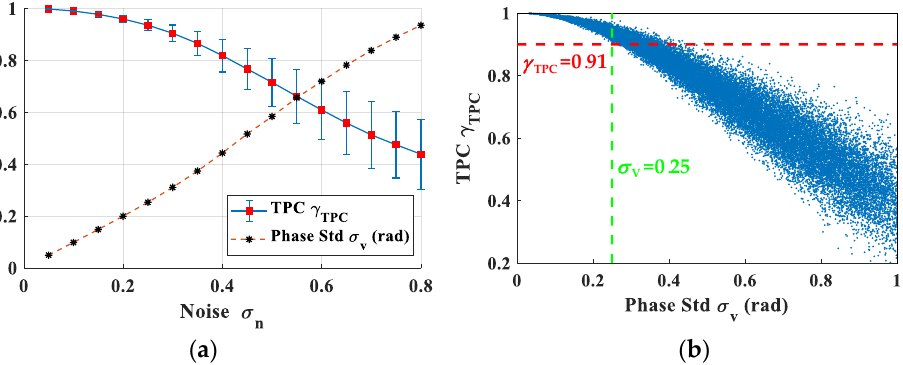
Figure 2. Numerical simulation results. ( a ) Variation curves of the temporal phase coherence (TPC) γ TPC and phase std σ V with the noise deviation σ n ; ( b ) scatter map of γ TPC with σ V . To better illuminate the relationship between the TPC γ TPC and the ADI D A , Figure 3a shows the scatter map of γ TPC with D A . By setting two proper thresholds of γ T and D T , those pixels with γ TPC ≥ γ T and D A > D T in the set S 3 could be selected as QPSs. For those pixels with the ADI D A lower than 0.25, and belonging to S 1 + S 2 , their TPC values are between 0.91 and 0.99 (90% confidence interval). The mean values (solid line) and the dispersion (error bars) of γ TPC with D A , are shown in Figure 3b. When D A equals to 0.25, the variation range of γ TPC is about from 0.91 to 0.96. Moreover, for those pixels with the TPC γ TPC larger than 0.91, and belonging to the set S 1 + S 3 , 99.99% of them are with the ADI D A lower than 0.45. Therefore, those pixels with the TPC γ TPC larger than 0.91, but with the ADI D A between 0.25 and 0.45, could be selected the